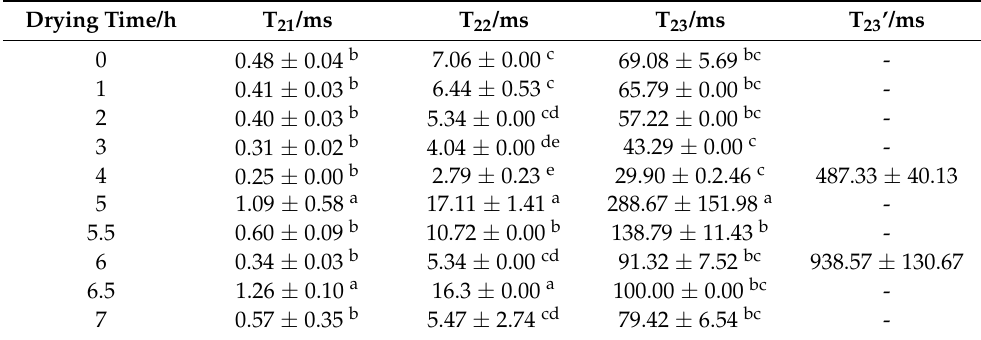
Table 1. Relaxation peak times of soybean dregs with different moisture contents. Drying